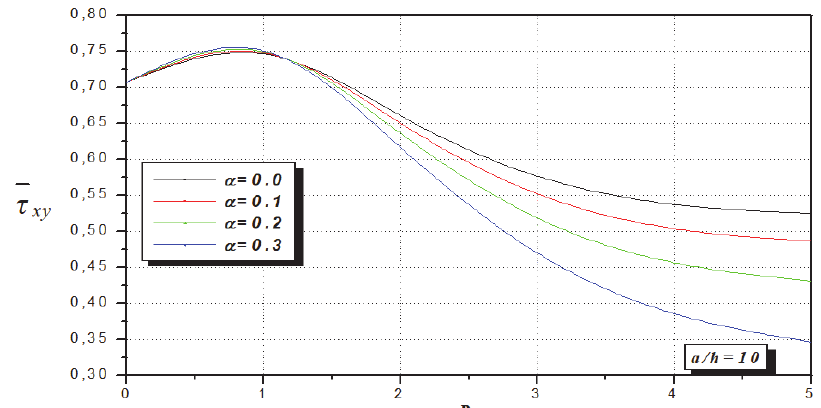
 as a function of the power index P and the different porosity factor α of xy